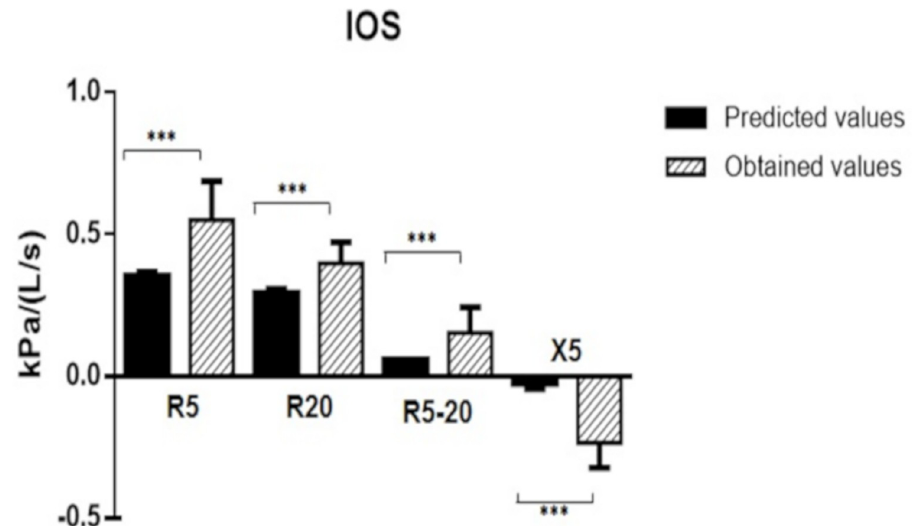
Fig 1. Impulse oscillometry measurements. Comparison of resistance at an oscillation frequency of 5 and 20 Hz (R5, R20, R5-20) and reactance at 5 Hz (X5) between the predicted and obtained values. ��� p < 0.05.